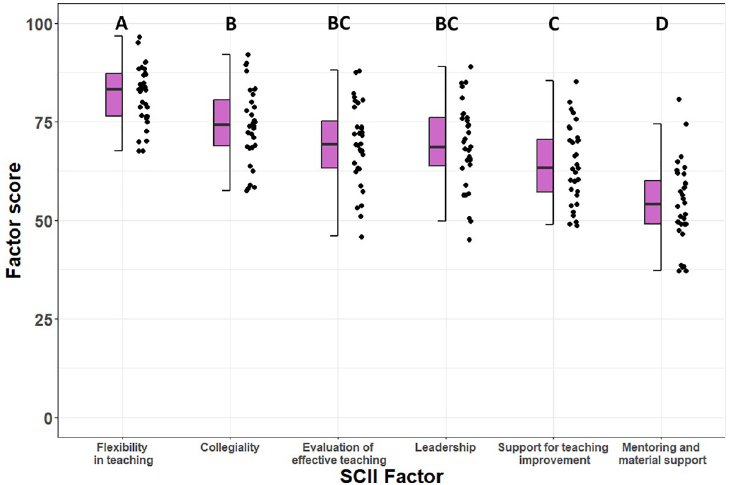
Fig 3. SCII factor scores for all institutions (N = 32). Letters represent significant differences among factors according to an ANOVA and Tukey HSD post hoc test.